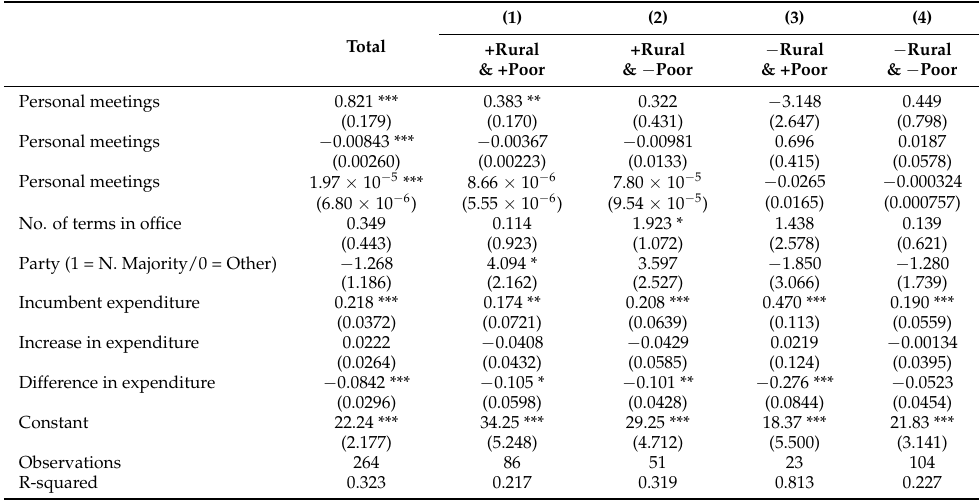
Table 4. Predictors of the percentage of turnout in the 2016 local